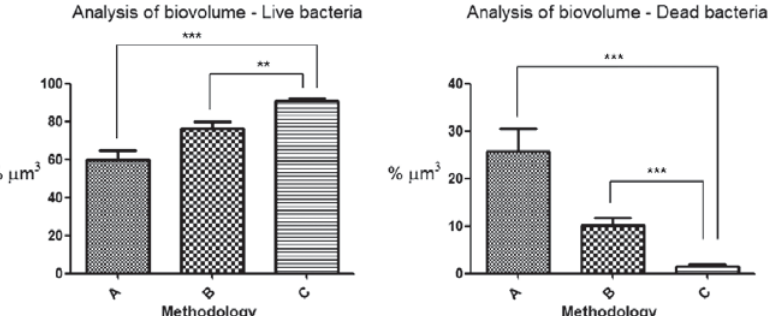
Figure 5- (cid:3)(cid:52)(cid:88)(cid:68)(cid:81)(cid:87)(cid:76)(cid:191)(cid:70)(cid:68)(cid:87)(cid:76)(cid:82)(cid:81)(cid:3)(cid:11)(cid:76)(cid:81)(cid:3)(cid:83)(cid:72)(cid:85)(cid:70)(cid:72)(cid:81)(cid:87)(cid:68)(cid:74)(cid:72)(cid:3)(cid:82)(cid:73)(cid:3)(cid:70)(cid:88)(cid:69)(cid:76)(cid:70)(cid:3)(cid:80)(cid:76)(cid:70)(cid:85)(cid:82)(cid:80)(cid:72)(cid:87)(cid:72)(cid:85)(cid:86)(cid:12)(cid:3)(cid:82)(cid:73)(cid:3)(cid:87)(cid:75)(cid:72)(cid:3)(cid:69)(cid:76)(cid:82)(cid:89)(cid:82)(cid:79)(cid:88)(cid:80)(cid:72)(cid:3)(cid:82)(cid:73)(cid:3)(cid:79)(cid:76)(cid:89)(cid:72)(cid:3)(cid:68)(cid:81)(cid:71)(cid:3)(cid:71)(cid:72)(cid:68)(cid:71)(cid:3)(cid:69)(cid:68)(cid:70)(cid:87)(cid:72)(cid:85)(cid:76)(cid:68)(cid:3)(cid:69)(cid:92)(cid:3)(cid:69)(cid:76)(cid:82)(cid:44)(cid:80)(cid:68)(cid:74)(cid:72)(cid:47)(cid:3)(cid:89)(cid:21)(cid:20)(cid:3) software, from confocal laser scanning microscopy (CLSM) images. The symbol ** shows the statistical difference between groups B and C in the analysis of biovolume of live bacteria (p<0.05), and the symbol *** shows the statistical differences between groups A and C in the analysis of biovolume of live bacteria, and between groups A and C, and B and C, in the analysis of biovolume of dead bacteria